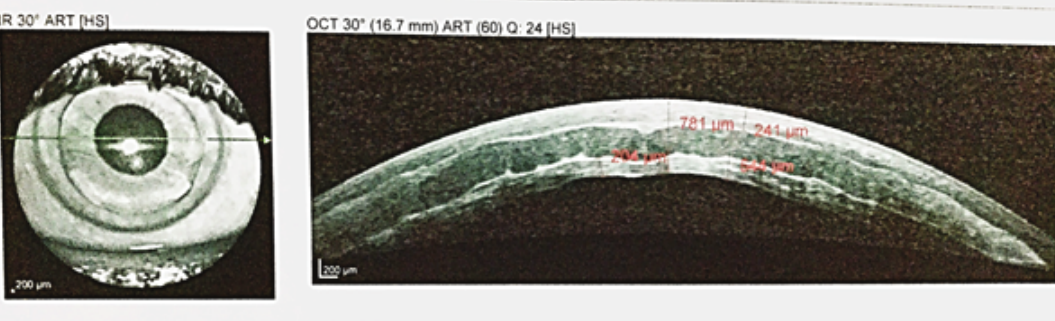
Figure 2. Anterior segment OCT of case number 2. Wrinkling of anterior and posterior interface can be